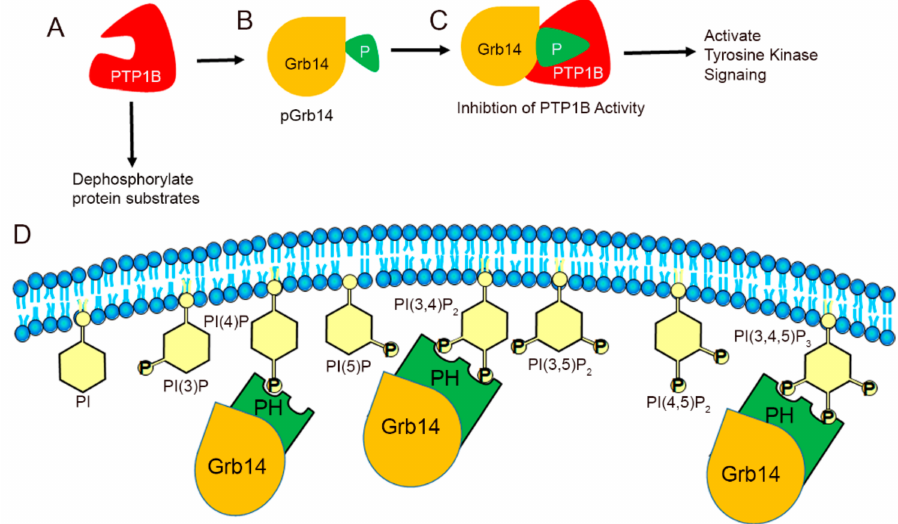
Figure 5. Mechanism of Grb14-mediated inhibition of PTP1B activity in the activation of the receptor tyrosine kinase signaling in the generation of PIPs. PTP1B dephosphorylates the protein substrates and inactivates the PI3K signaling ( A ). Grb14 undergoes phosphorylation ( B ) and the phosphorylated Grb14 binds PTP1B and inhibits its phosphatase activity ( C ), which results in the activation of the receptor tyrosine signaling, leading to the generation of PIPs ( C ). The interaction between PIPs and Grb14 ( D